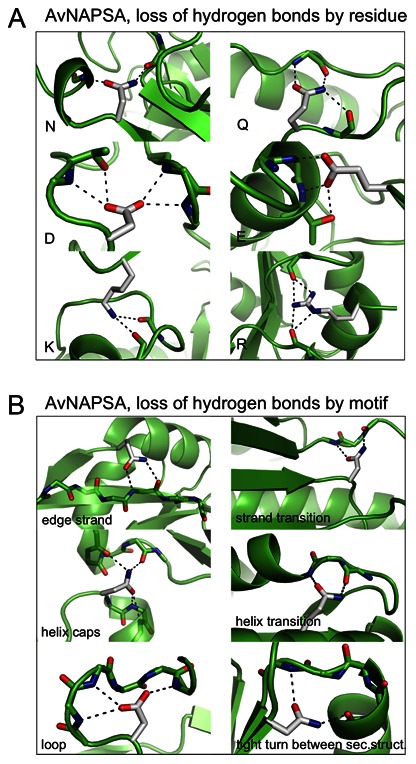
Specific examples of hydrogen bonds removed by AvNAPSA supercharge.In AvNAPSA designs, wild-type surface residues forming hydrogen bonds can be mutated (white sticks show the native side chain). A) Mutation of surface NQ/DE/RK residues can lead to loss of hydrogen bonds. B) Common sidechain-backbone hydrogen bonding motifs at protein surfaces mediate direct interaction with secondary structure elements and interaction with regions that transition between secondary structure elements. N and Q residues can act as both donor and acceptor, illustrating the risk of automated N to D and Q to E mutations.